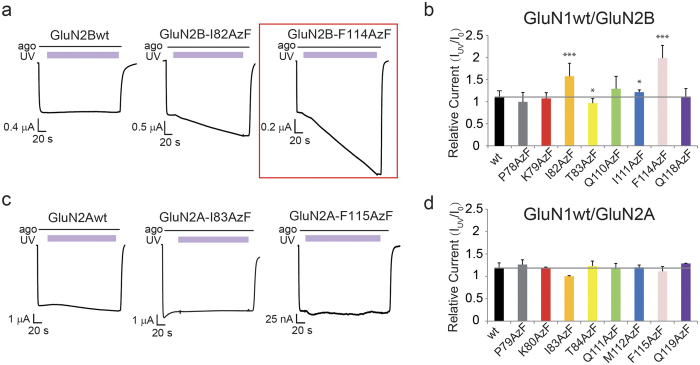
UV sensitivity of AzF mutant receptors.(a) Representative current traces measured from oocytes expressing wt and AzF mutant receptors during UV illumination. Two GluN2B mutants (GluN1/GluN2B-I82AzF and GluN1/GluN2B-F114AzF) showed UV-induced potentiation. (b) Relative currents (Iuv/Io) measured on oocytes expressing GluN2B receptors of AzF mutants: GluN2Bwt (1.08 ± 0.12, n = 26), GluN2B-P78AzF (0.99 ± 0.21, n = 4), GluN2B-K79AzF (1.07 ± 0.13, n = 4), GluN2B-I82AzF (1.57 ± 0.30, n = 5), GluN2B-T83AzF (0.97 ± 0.10, n = 9), GluN2B-Q110AzF (1.29 ± 0.28, n = 3), GluN2B-I111AzF (1.21 ± 0.05, n = 2), GluN2B-F114AzF (1.97 ± 0.29, n = 21), GluN2B-Q118AzF (1.11 ± 0.18, n = 5). (c) AzF mutations in homologous sites in GluN2A and GluN2A wild-type receptors had no UV sensitivity. (d) Relative currents (Iuv/Io) measured on oocytes expressing GluN2A receptors of AzF mutants: GluN2A wt (1.18 ± 0.12, n = 11), GluN2A-P79AzF (1.26 ± 0.11, n = 3), GluN2A-K80AzF (1.17 ± 0.03, n = 3), GluN2A-I83AzF (1.00 ± 0.02, n = 2), GluN2A-T84AzF (1.23 ± 0.11, n = 13), GluN2A-Q111AzF (1.17 ± 0.12, n = 4), GluN2A-M112AzF (1.20 ±  ± 0.05, n = 2), GluN2A-F115AzF (1.11 ± 0.11, n = 7), GluN2A-Q119AzF (1.29 ± 0.003, n = 2).